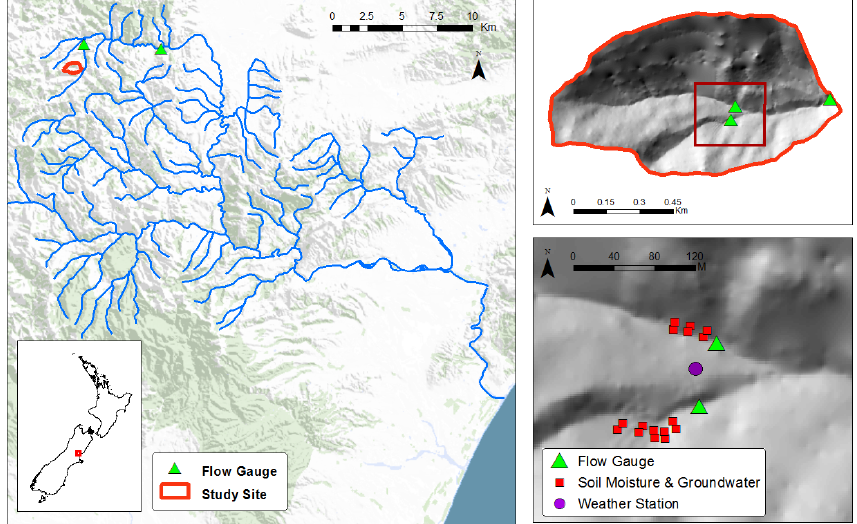
Figure 1. Catchment location and instrumentation.